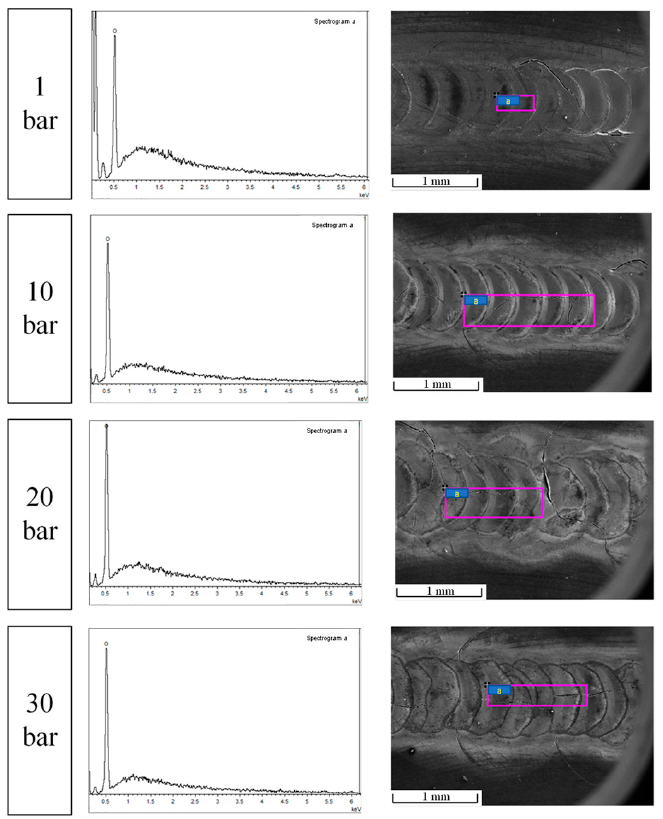
Figure 5. Surface energy spectrum results of beryllium laser melting (“a” represents the corresponding analusis area).